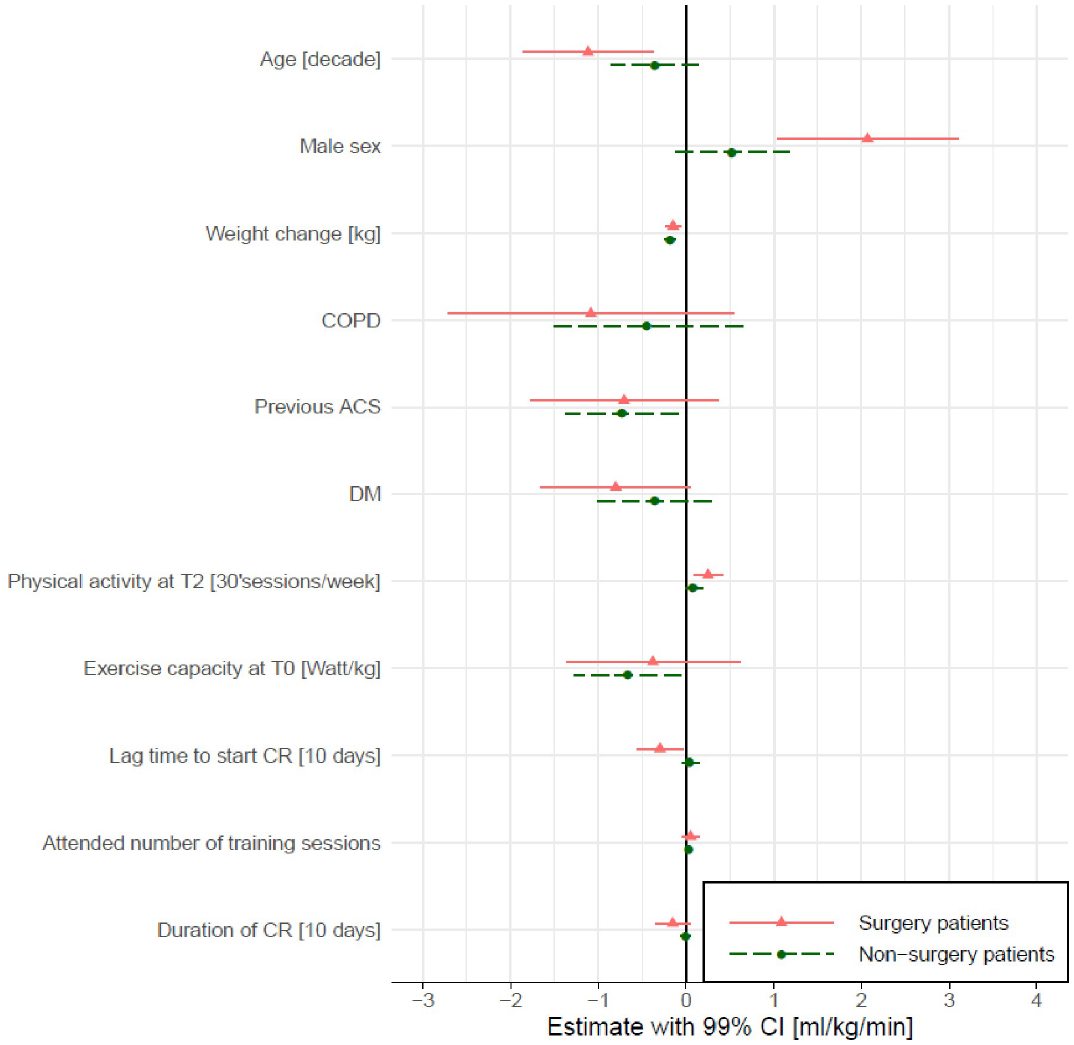
Fig 2. Predictors for change in peak VO 2 in the 468 surgery and 773 non-surgery patients. Shown are estimates and 99% confidence intervals of included parameters from the separate robust linear mixed regression models for change in peak VO 2 from T0 to T2 for the two sub-populations. CRF at T0, attended number of training sessions, inactivity, lag time to CR start and duration of CR were included a priori. The other variables were significant variables in the model for the pooled data but shown here for the surgery and non-surgery populations separately. Centre was included as random factor. COPD, chronic obstructive pulmonary disease; ACS, acute coronary syndrome; DM, diabetes mellitus; CR, cardiac rehabilitation.